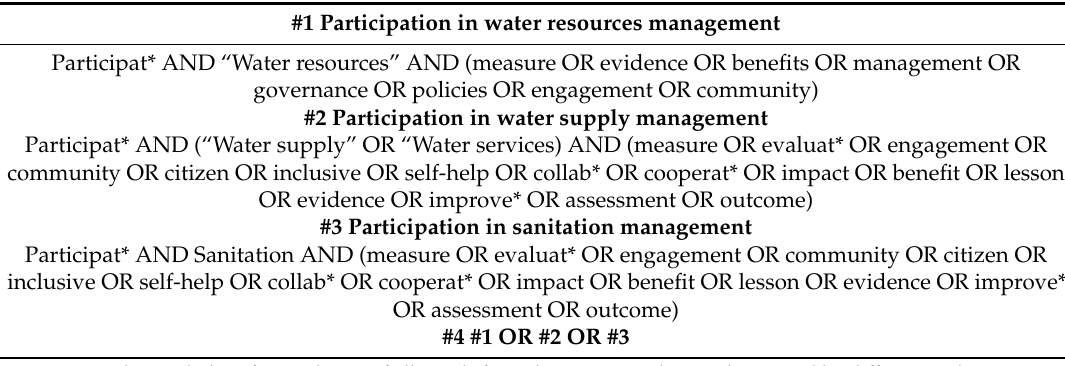
Table 1. Keywords and syntax used for literature